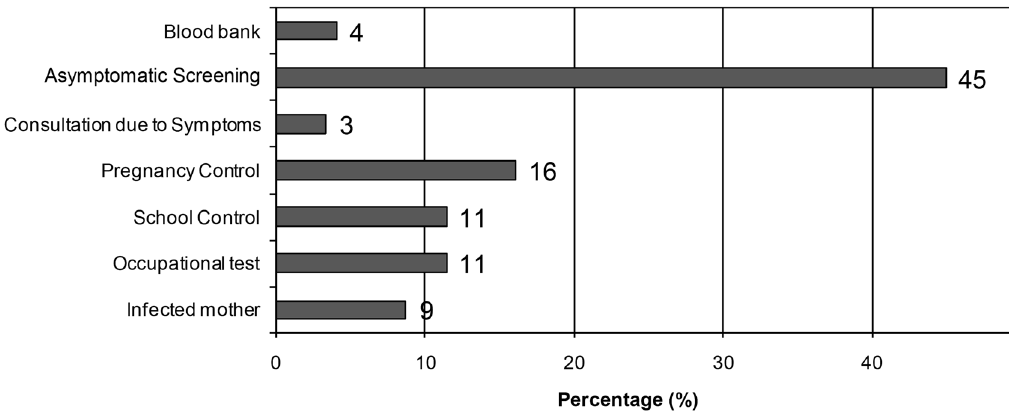
Figure 2. Method for detection of T.cruzi infection in 144 mothers.